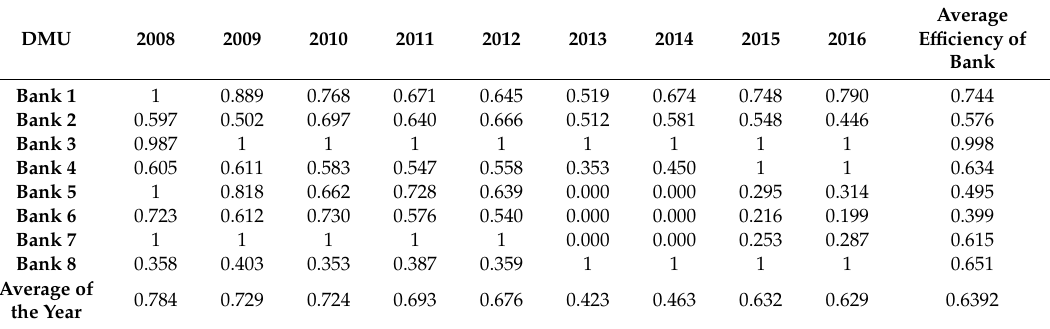
Table 12. Results of DEA model 4 (Input oriented, VRS, input Deposits, and output Mortgage Credits).